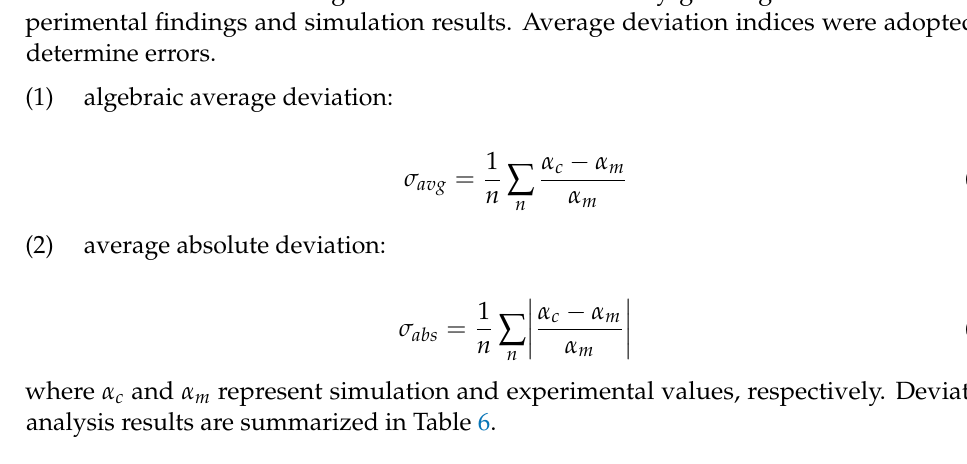
Table 6. Difference between the measured value and simulated value. The Average